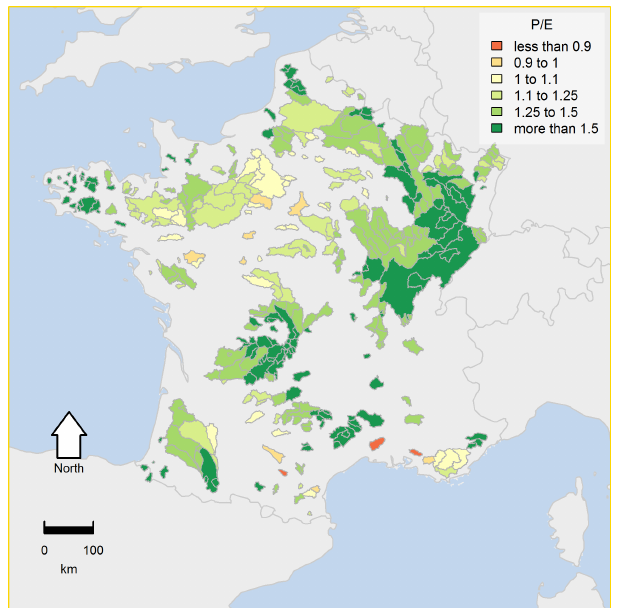
Figure 3. Map of the French catchments used in this study. The humidity index is defined as the ratio between average precipitation and average potential